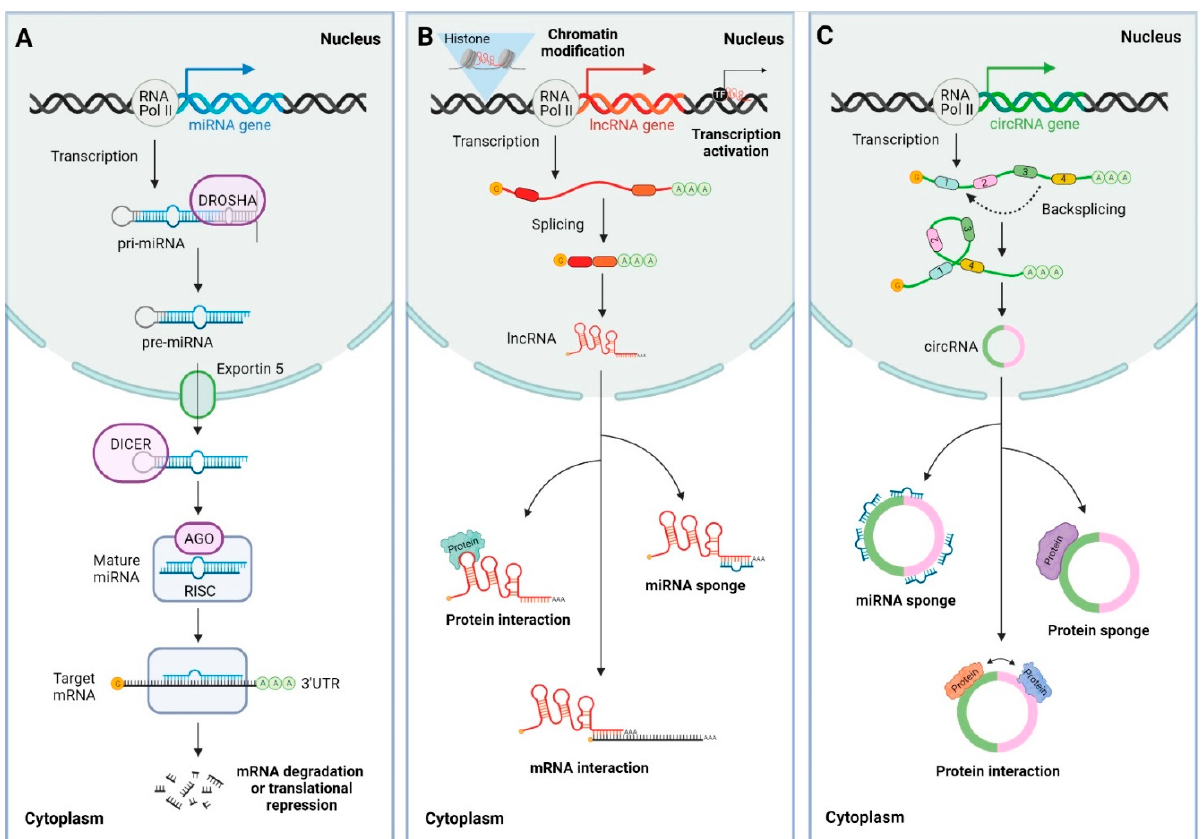
Figure 1. Biogenesis and functions of microRNAs (miRNAs), long non-coding RNAs (lncRNAs) and circular RNAs (circRNAs). ( A ) MiRNAs are transcribed from genomic DNA by RNA polymerase II as primary miRNAs (pri-miRNAs). The pri-miRNAs are processed in the nucleus by Drosha producing precursor miRNAs (pre-miRNAs) which are exported to the cytoplasm by exportin 5. The pre-miRNAs in the cytoplasm are processed by Dicer, which cleaves the hairpin structure and produces a miRNA duplex. The miRNA duplex is loaded to Argonaute (AGO), which binds the guide strand and forms the RNA-induced silencing complex (RISC). The mature miRNAs guide the RISC complex to bind their cognate sites in the 3 ′ untranslated regions (3 ′ UTR) of the target messenger RNA (mRNA) through imperfect base pair complementarity and induce its translational repression or degradation, thus exerting post-transcriptional gene regulation. ( B ) LncRNAs are transcribed from DNA by RNA polymerase II, similarly to miRNAs. Some lncRNAs undergo splicing and are 5 ′ capped and 3 ′ polyadenylated. LncRNAs function in the nucleus inducing chromatin modification and regulating cis and trans gene expression interacting with transcription factors (TFs). In addition, lncRNAs can exit the nucleus and exert different roles in the cytoplasm functioning as miRNA sponges and interacting with proteins and mRNAs to induce or repress their translation. ( C ) CircRNAs are transcribed from DNA by RNA polymerase II and are generated by backsplicing of exon or intronic regions. CircRNAs exit the nucleus and may function as miRNA and protein sponges or as scaffolds for protein interaction.